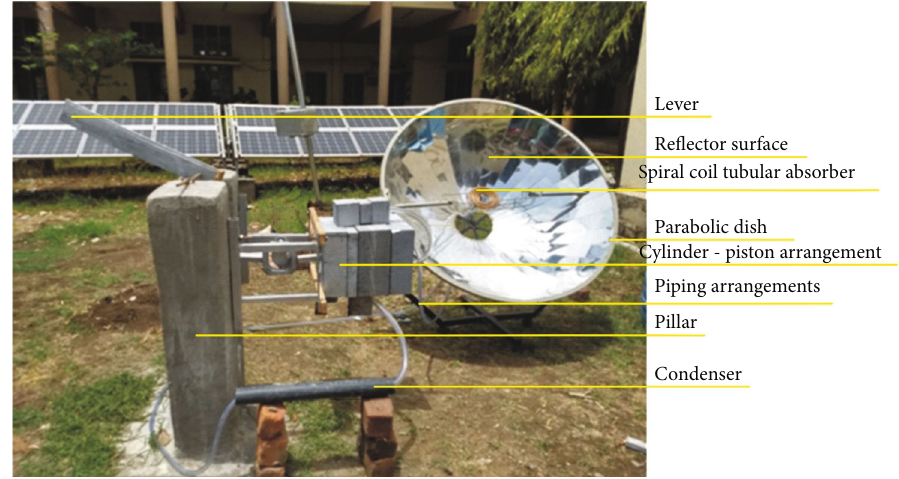
Figure 12: Modi fi ed solar thermal absorber installed in SPDC for solar water thermal pump system.